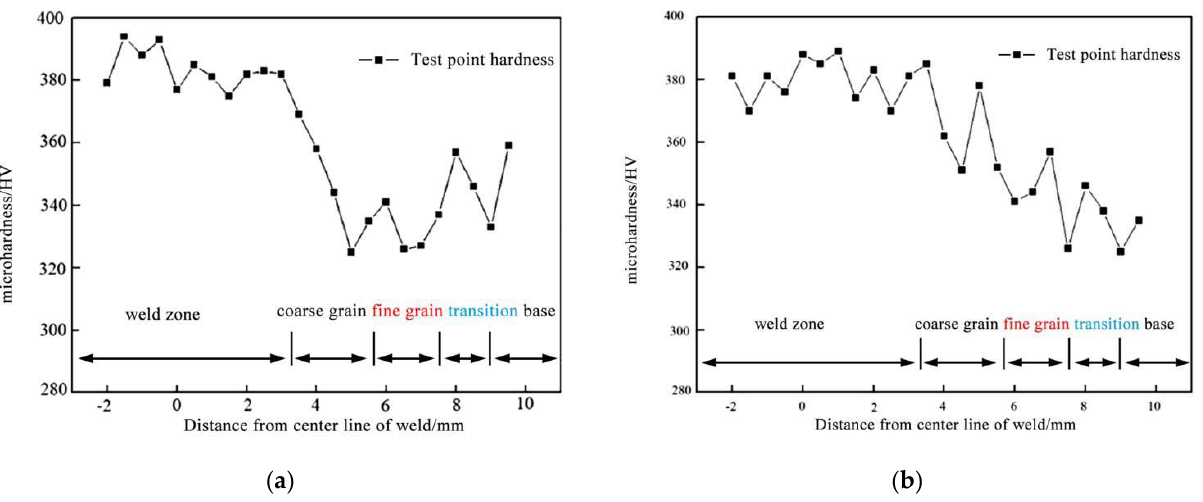
Figure 11. Micro-hardness of the weld joint, ( a ) bypass hot wire plasma arc welding joint, and ( b ) traditional filler wire plasma arc welding joint.